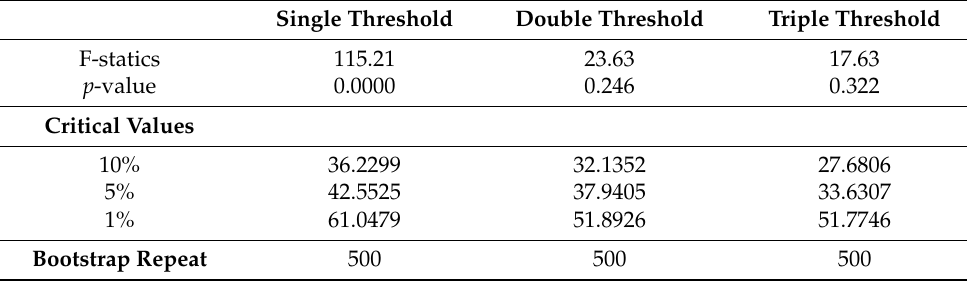
Table 9. Threshold effect test estimations.